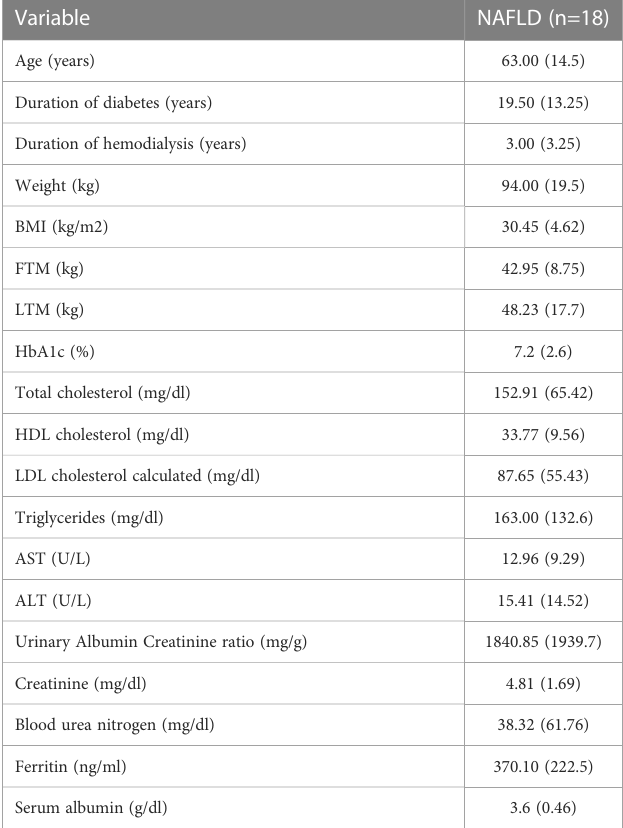
TABLE 1 Population general characteristics.